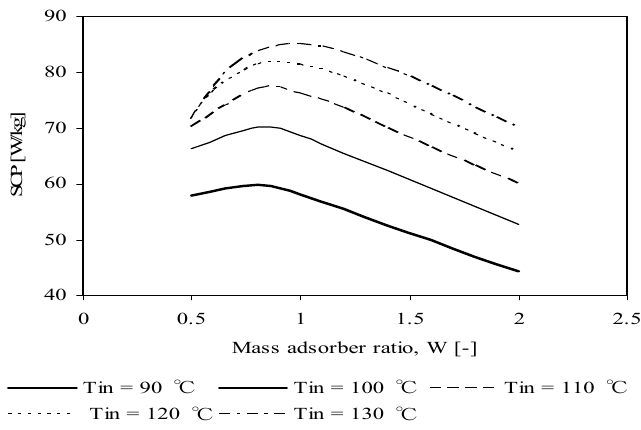
Figure 8. The influence of the mass adsorber ratio on the